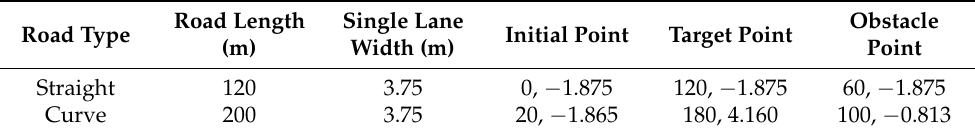
Figure 8. Road environments. ( a ) Straight road environment. ( b ) Curved road environment. Table 1. Road parameters.